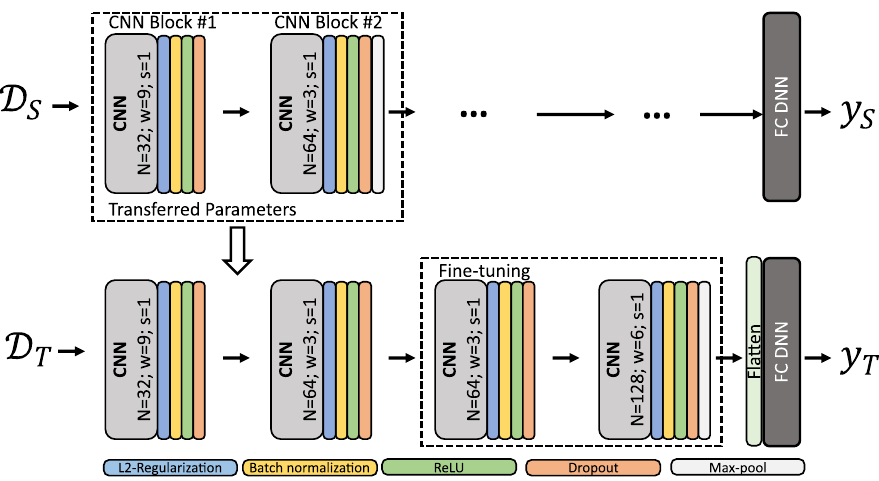
Figure 6. Schematic of deep transfer learning approach. D S refers to input data from a source domain, in this case a HAR dataset, to learn a task T S , which is represented by the label space Y S (the HAR activity classes). D T refers to the target domain, in this case the FLOODLIGHT data, where Y T are the disease classification outputs of HC, PwMSmild or PwMSmod for target task T T . During transfer learning, a model’s parameters and learned weights, f ( · ) of D S , are then used to initialise and train a model on target domain D T and task T T . Transfer learning is then performed by transferring the source model’s layers (where these weights and parameters are “frozen”) to subsequently re-train a new model (i.e. fine-tune) using D T data for the new target task, T T . Downstream layers in the network are fine-tuned towards this new target task decision Y S